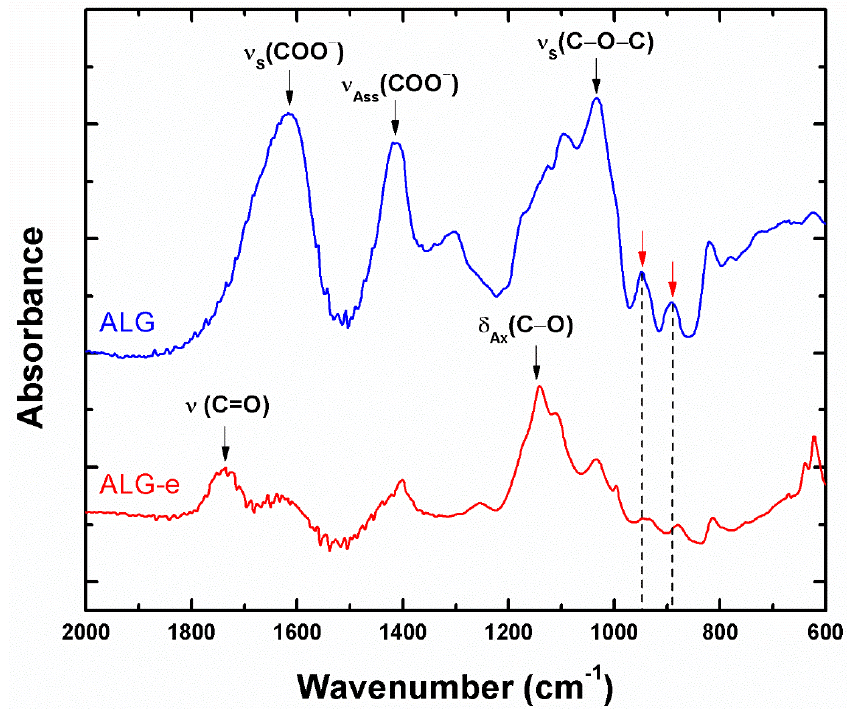
Figure 2. FTIR spectra of alginate (ALG) and esterified alginate (ALG-e).